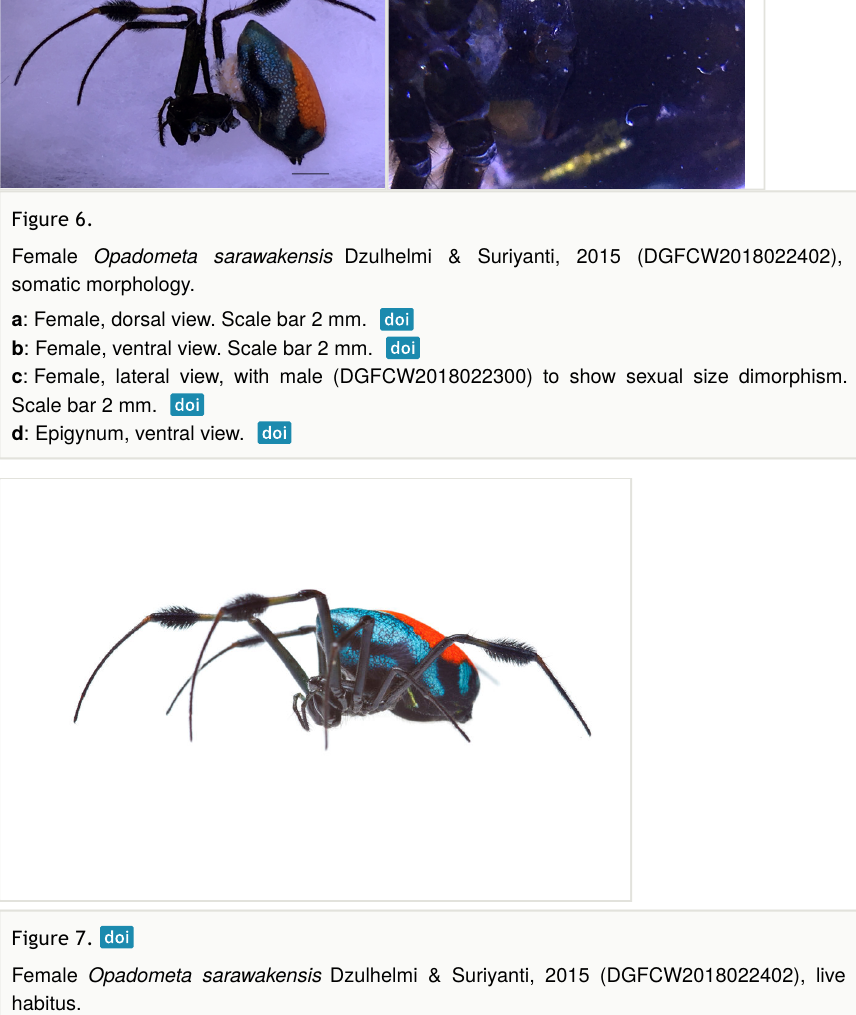
Figure 7. Female Opadometa sarawakensis Dzulhelmi & Suriyanti, 2015 (DGFCW2018022402), live